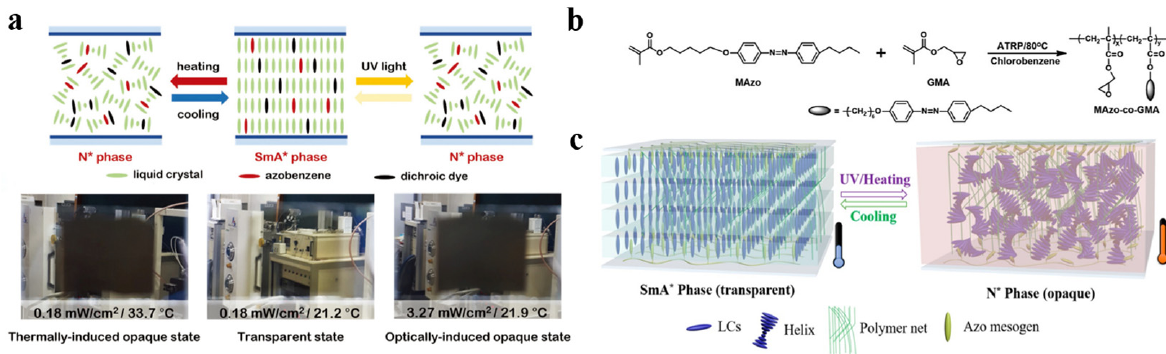
Figure 6. ( a ) Schematic diagram and images of TR/PR LC smart window in two working modes [93]. ( b ) Synthetic route of the copolymer MAzo- co -GMA alignment agent [94]. ( c ) Working principle of TR/PR LC smart window based on the MAzo- co -GMA alignment layer [94].